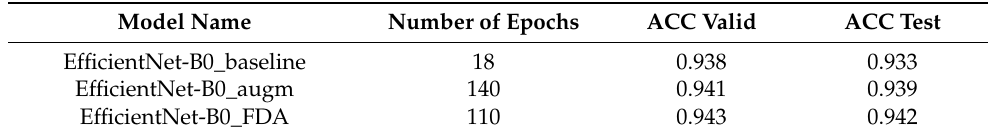
Table 5. The value of the target metric of the model accuracy on the validation and test sample for different model training strategies.